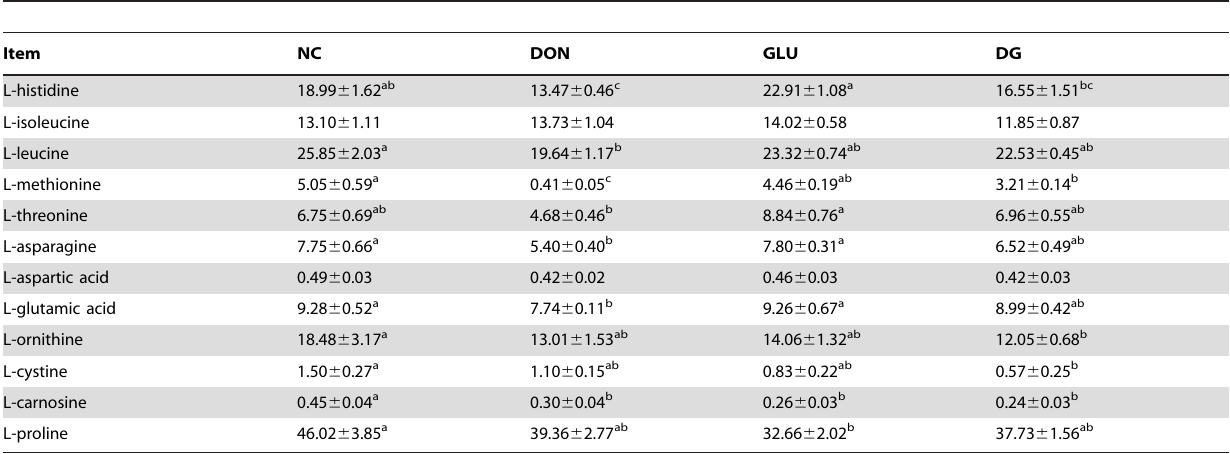
Table 4. Effect of dietary supplementation with glutmic acid on serum amino acids levels ( m g/ml) in piglets fed a deoxynivalenol- contaminated diet on day